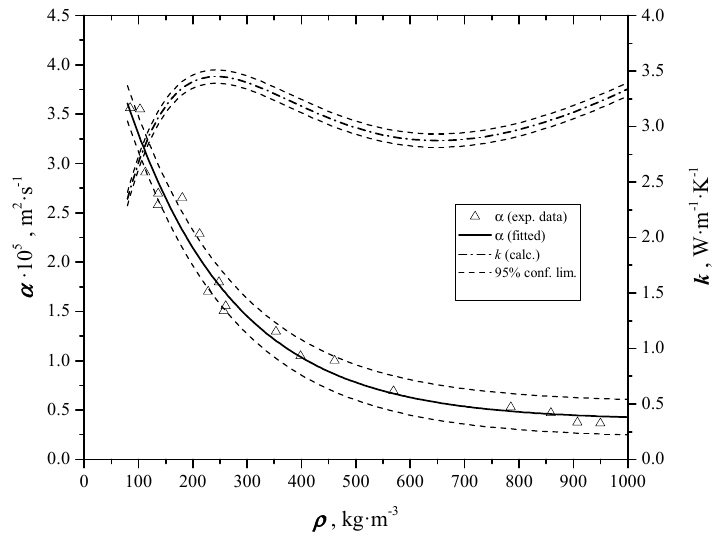
Figure 1. Trend of thermal diffusivity α and thermal conductivity λ as a function of density ( ρ ) [6]. Samples measured and reported in [6], see Figure 2, had been blackened with a thin layer of colloidal graphite (Aquadag ® ) in order to increase the emissivity of their surface. A higher